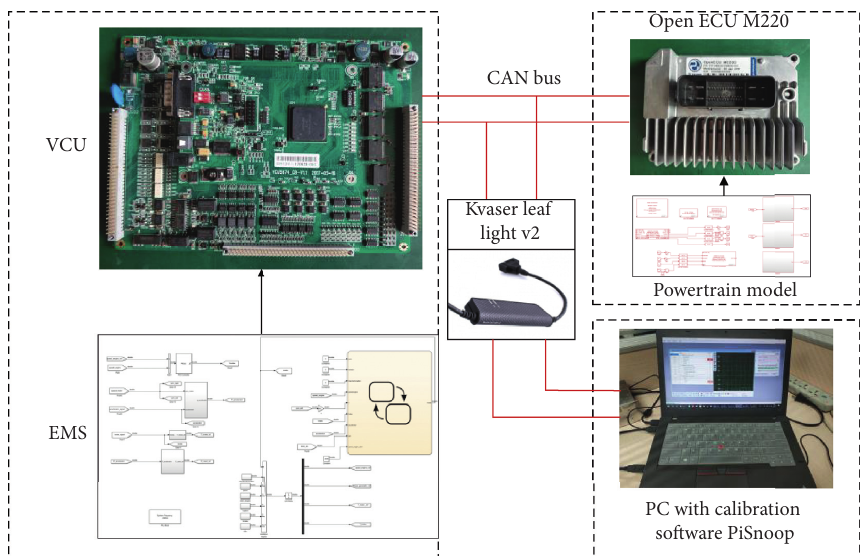
Figure 13: Schematic diagram of HIL test platform for EMS.